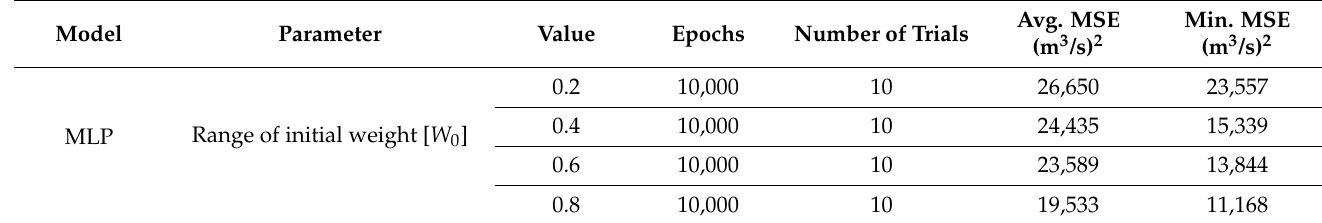
Table 4. Sensitivity analysis of MLP model parameters.